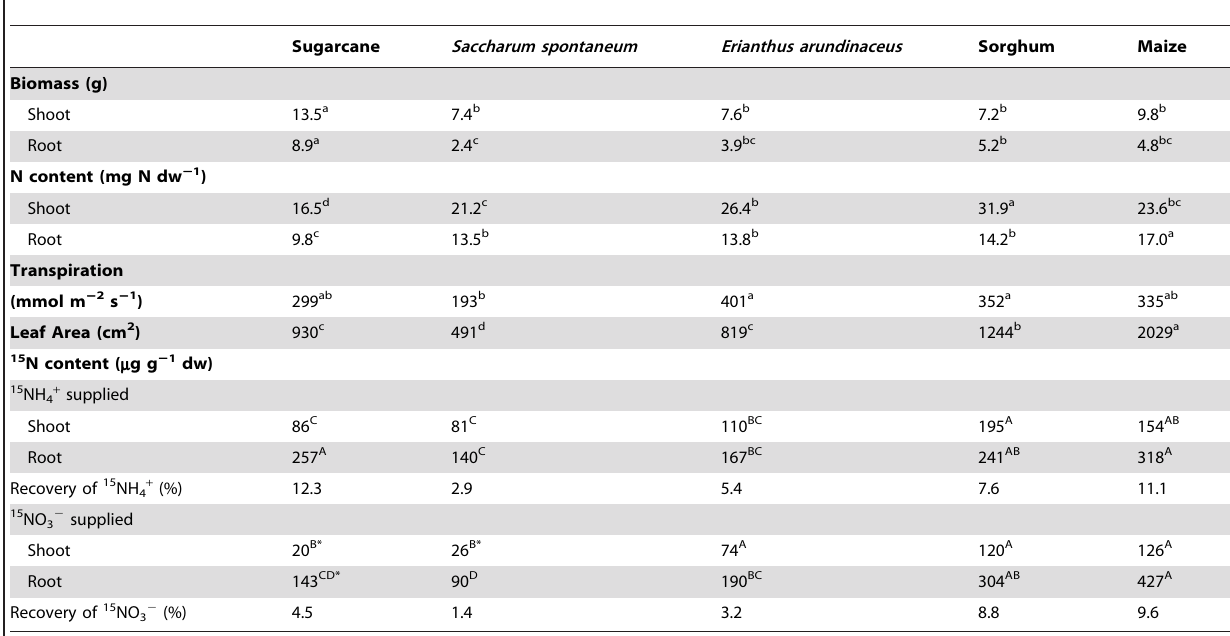
Table 2. Biomass, N content, transpiration and 15 N tissue concentration and recovery of sugarcane and related species after 5 weeks growth with adequate N